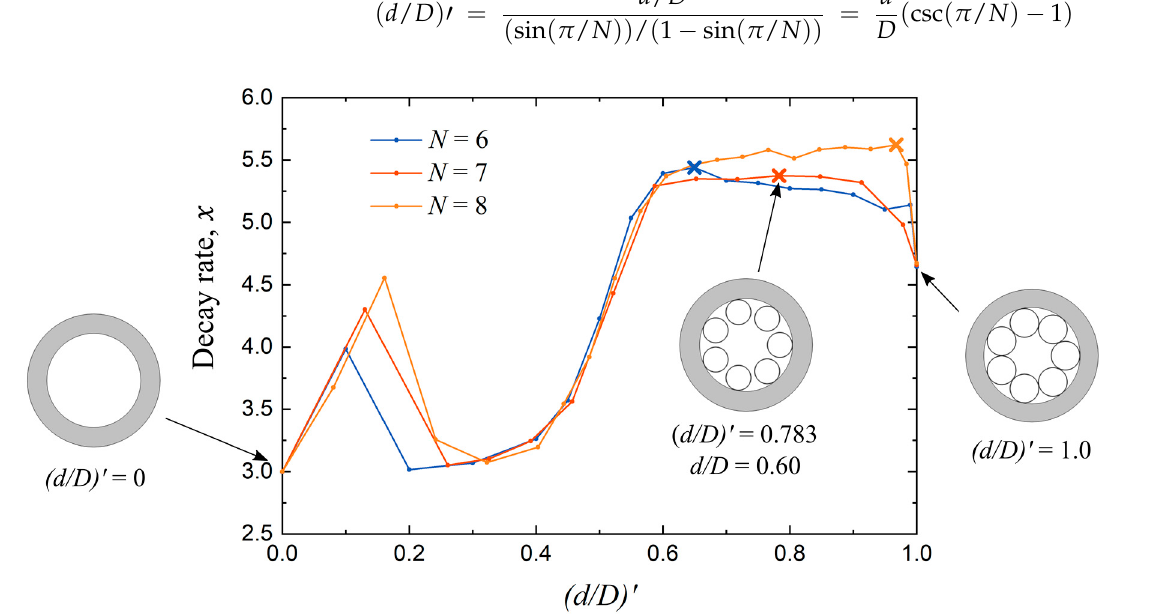
Figure 6. Confinement loss decay rate, x , versus the standardized cladding size, ( d / D ) (cid:48) , for THCF when N = 6, 7, 8, and F = 0.5. The decay rate, x , means α dB is proportional to λ x − 1 / D x . At each data point, x is calculated by fitting the (cid:61) ( n eff ) versus G plot using the least squares method in the range 20 < G < 40. The standardized cladding size, ( d / D ) (cid:48) , is obtain by normalizing d / D to its respective maximum, sin ( π / N ) / ( 1 − sin ( π / N )) . Example geometries at three different ( d / D ) (cid:48) values when N = 7 are illustrated in the insets for reference. The colored crosses mark ( d / D ) (cid:48) values that give the lowest loss in each N which coincides with the largest decay